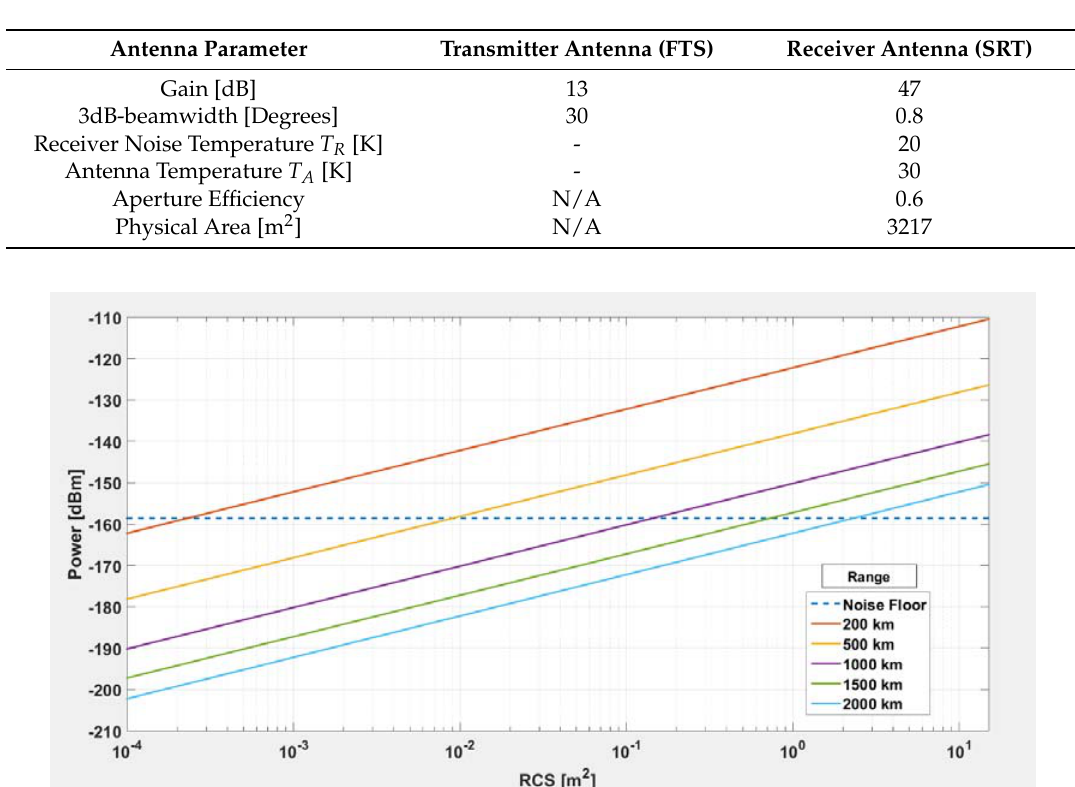
Table 1. Main features of the BIRALET radar